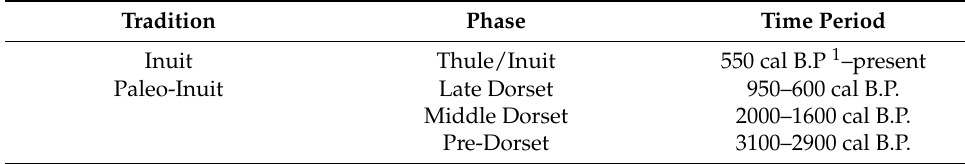
Table 1. Date ranges for the four major periods of occupation at Iqaluktuuq.